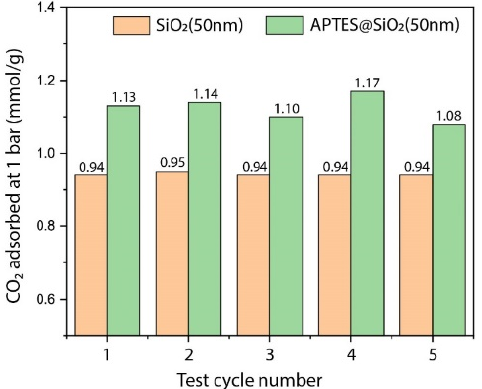
Figure 12. Stability of pristine and functionalized 50 nm SiO 2 nanoparticles under repeated adsorption-desorption cycles at 25 °C and up to 1 bar.